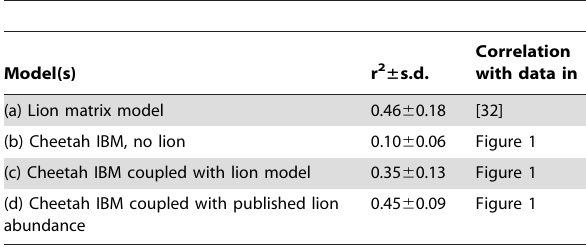
Table 2. R-squared values of models.